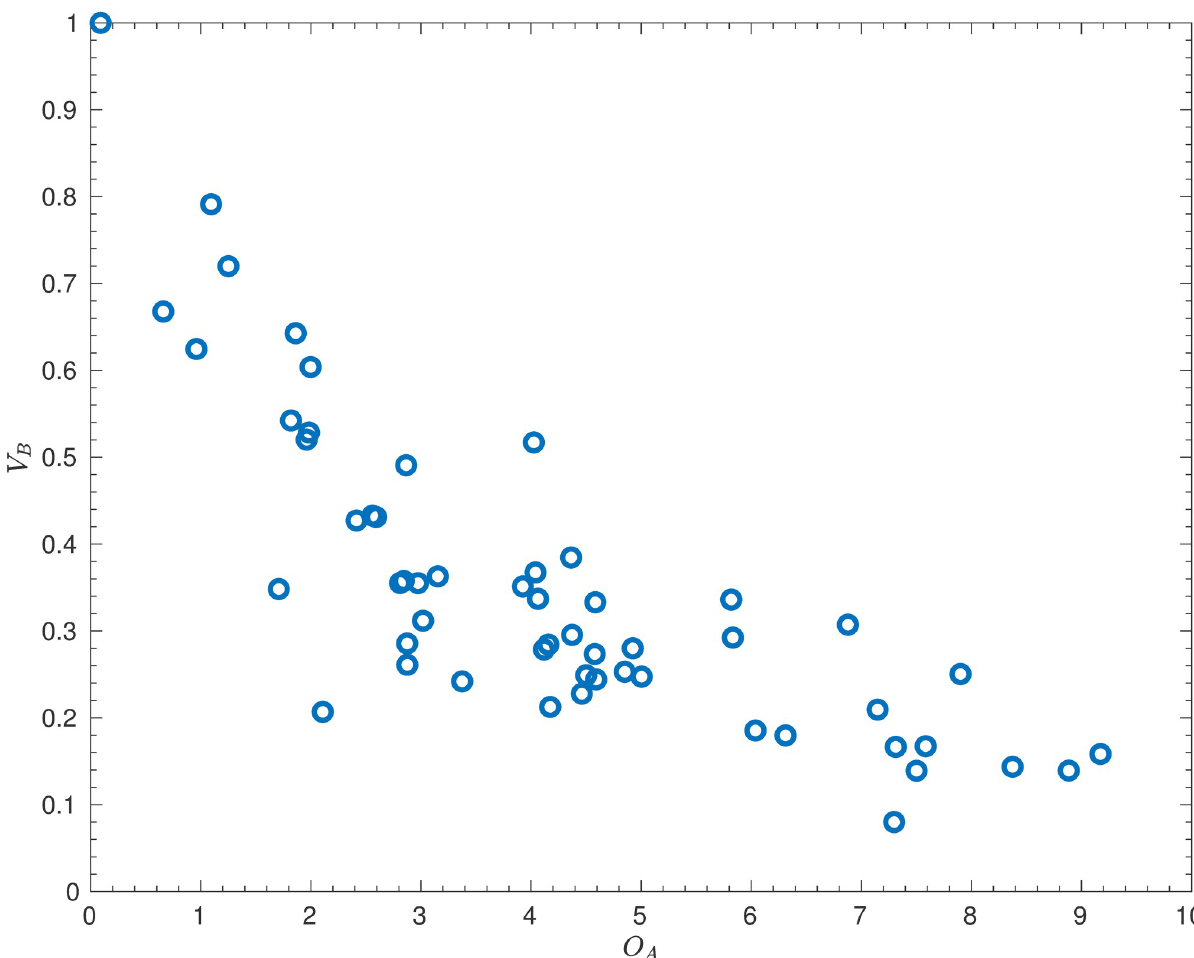
Fig 2. Initial paramter values. The values of the attacking strengths, O using matches between July 16, 2018 and May 28, 2021. Note that the parameters have been normalised so that the maximum defensive vulnerability is equal to